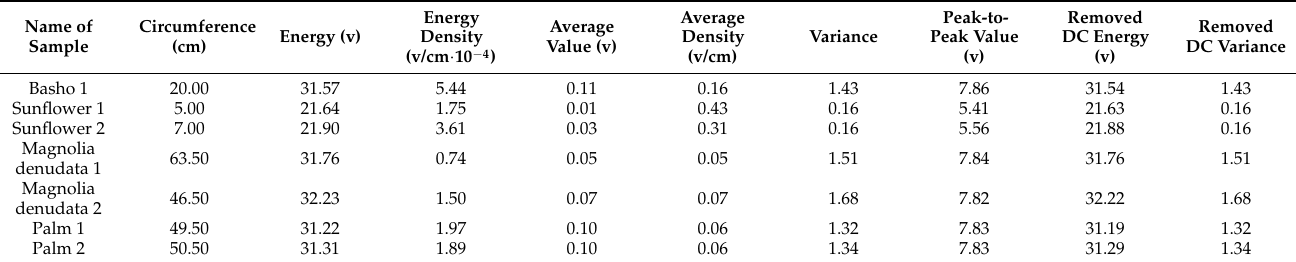
Table 5. Ultrasound energy features of plant stems in time domain.